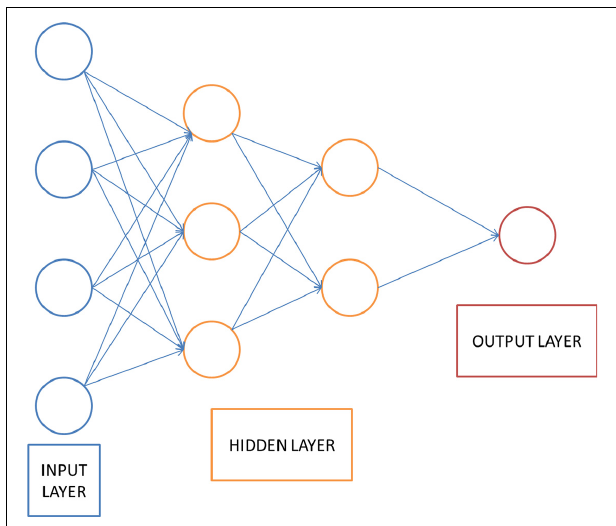
FIGURE 2 | DNN structure.